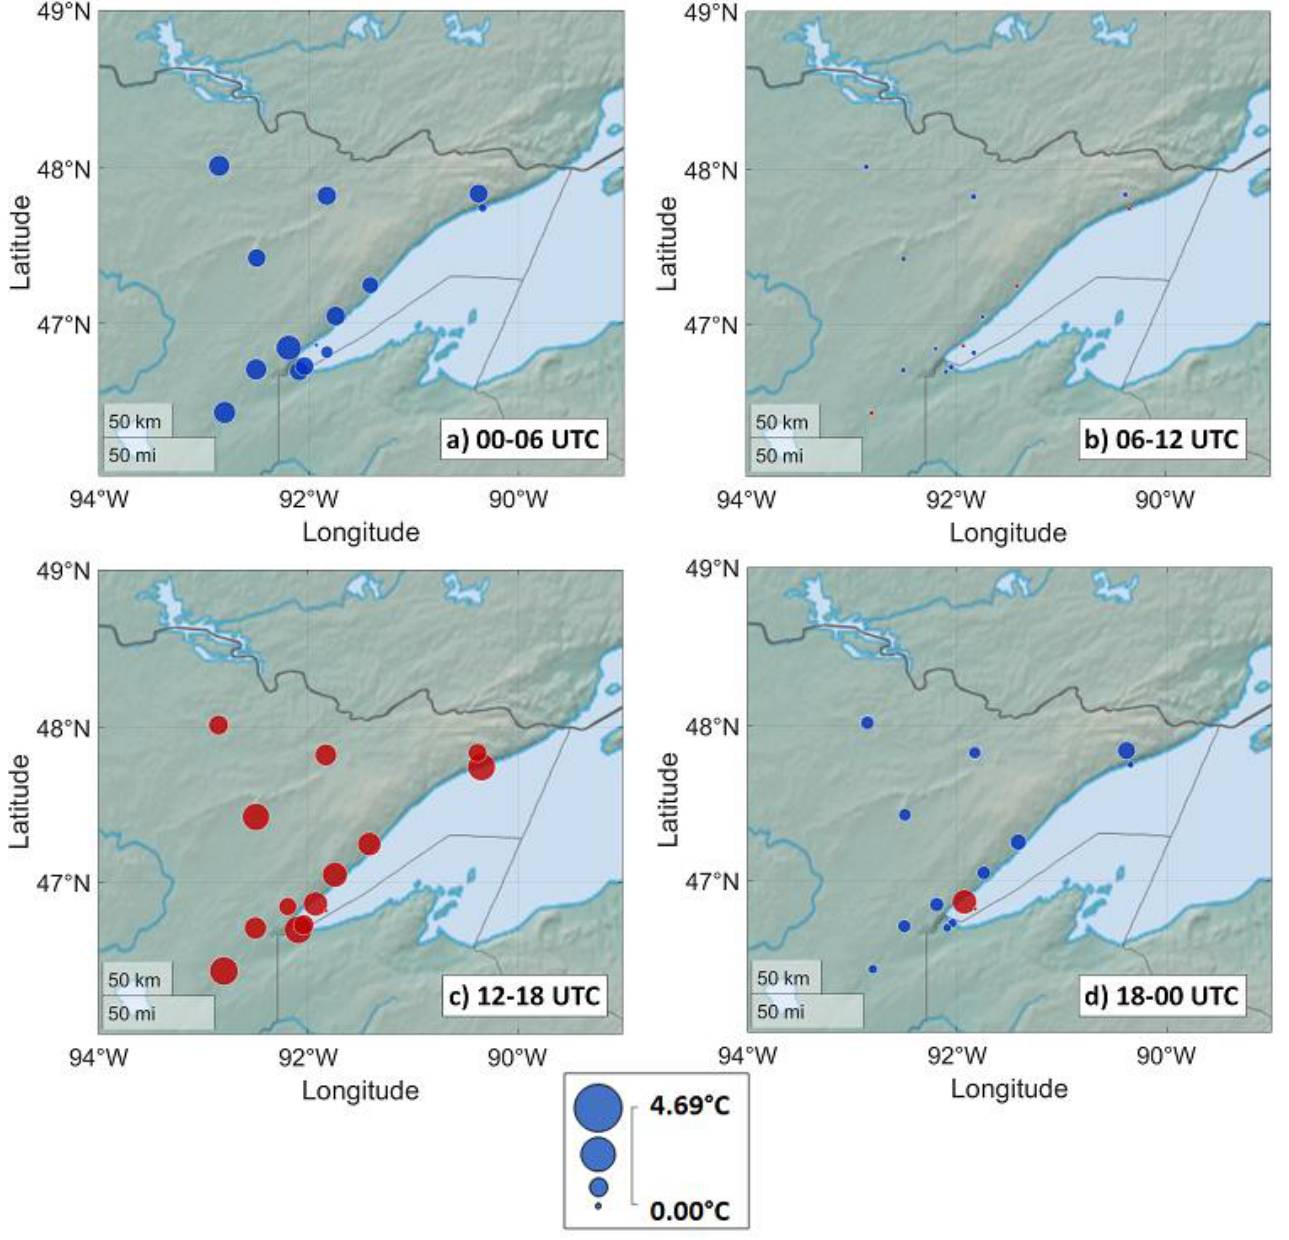
Figure 6. As in Figure 3, except for average temperature change by time of day: ( a ) 00–06 UTC; ( b ) 06 – 12 UTC; ( c ) 12 – 18 UTC; ( d ) 18 – 00 UTC. Red (blue) bubbles indicate increasing (decreasing) temperature.